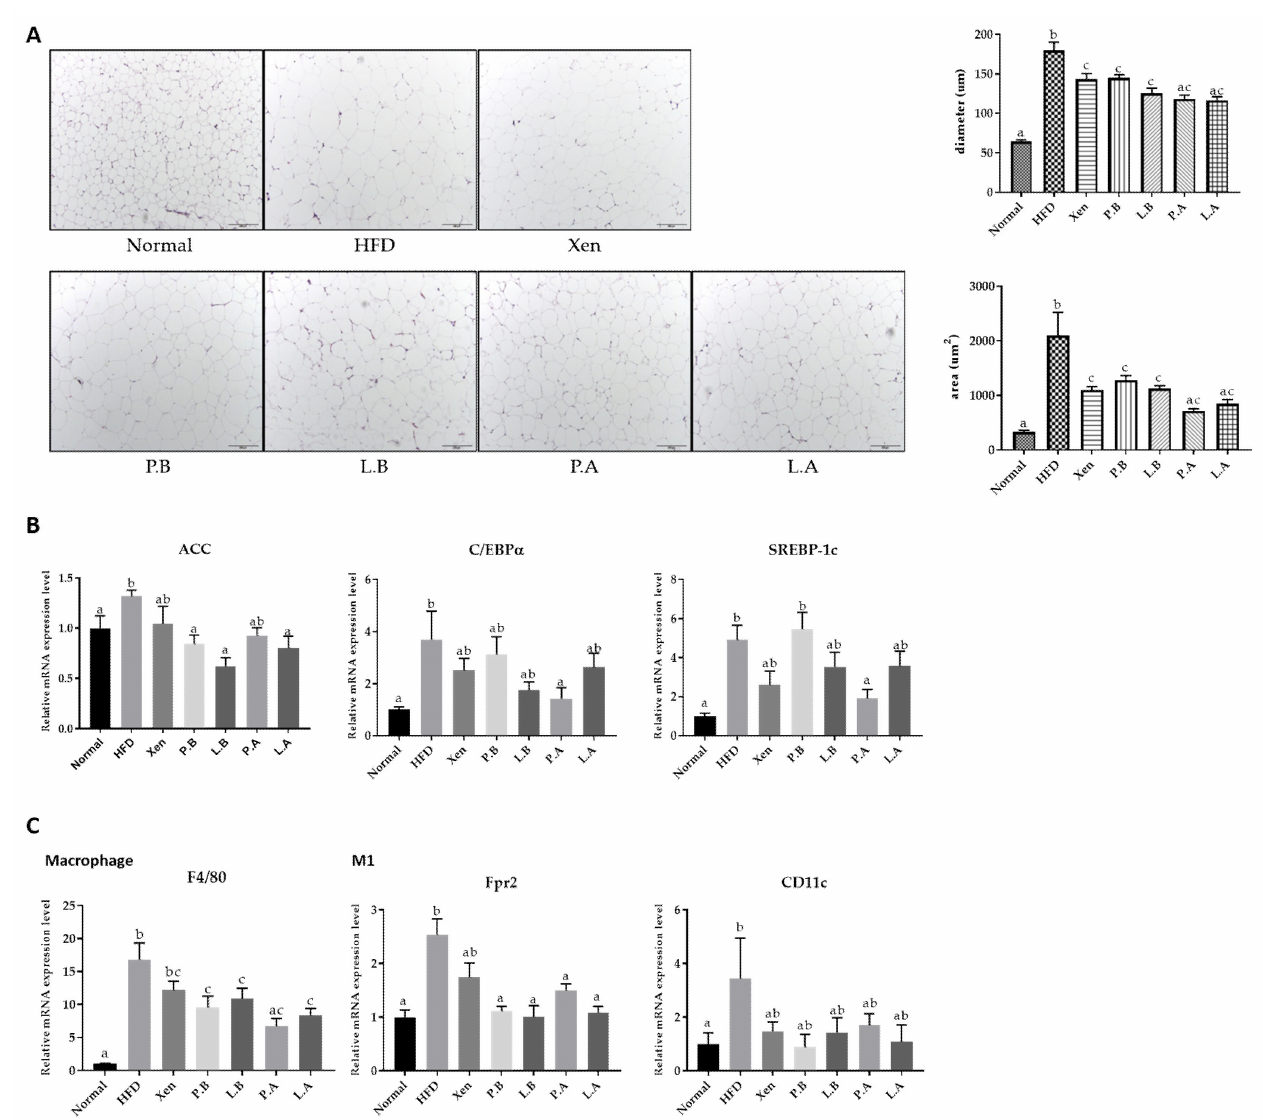
Figure 4. Effect of bacteria on the adipose tissue in the HFD mice. ( A ) Histological analysis (H&E staining) on epididymal fat tissue sections (scale bar, 100 µ m). ( B ) Representative mRNA expression levels of the ACC, C/EBP α and SREBP-1c as lipid metabolism markers. ( C ) Percentage expression of macrophages in the epididymal fat tissue. The data are expressed as means ± SD; the differences were statistically evaluated using one-way ANOVA. Means without a common letter significantly differ, p < 0.05. HFD, high-fat diet; Xen, orlistat, P.B, pasteurized BAA-835; L.B, live BAA-835; P.A, pasteurized A. muciniphila ; L.A, live A. muciniphila